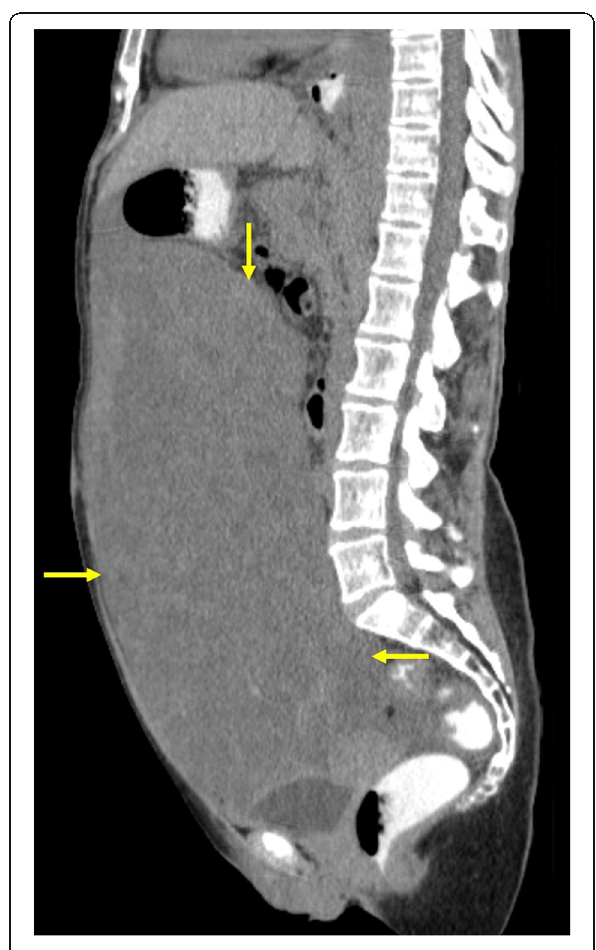
Fig. 1 Sagittal pre-contrast MDCT image at midline. The tumour (yellow arrows) is heterogeneous and well